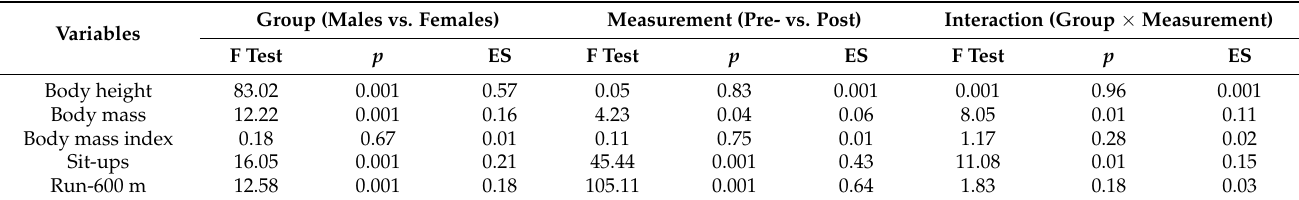
Table 3. Results of the repeated measurement factorial analysis of the variance (ANOVA) for the lockdown generation with gender (males vs. females) as the group-factor, with F-test, p -level, and effect size (ES) reported. Group (Males vs. Females) Variables Body height